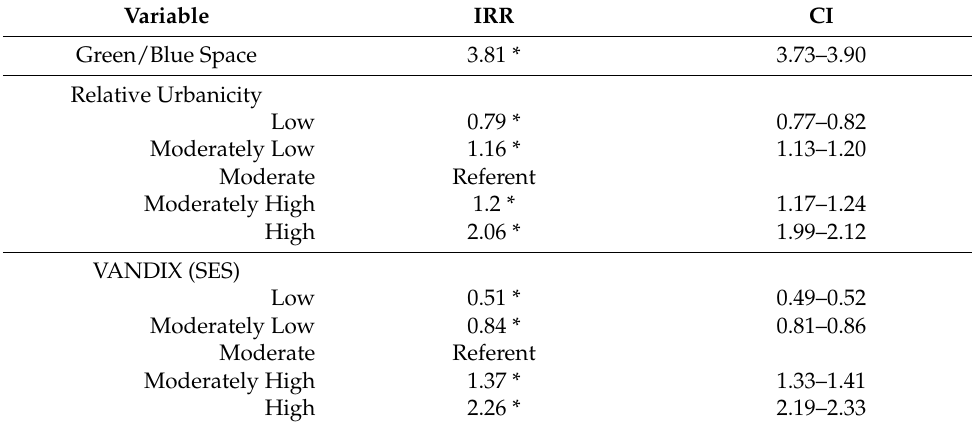
Table 2. Overall Running Activities.